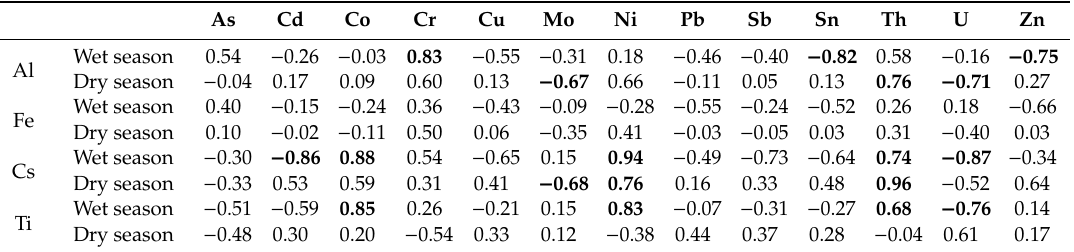
Figure 8. Comparison of EF calculated for each TE using di ff erent normalizers (Al, Cs, Fe, and Ti). GNB, geochemical natural background limit. Correlation matrix (r, Pearson correlation coe ffi cient) between the di ff erent TE and the normalizing elements, Al, Fe, Cs, and Ti. The bold numbers have p -values at a 5% significance